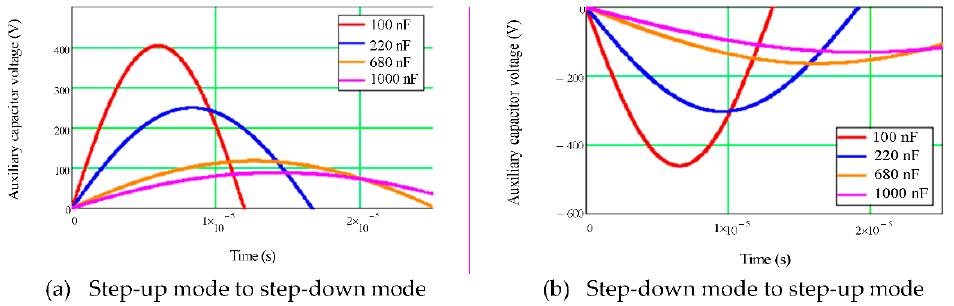
Figure 17. The transition time curve with different auxiliary capacitor values under the full- condition. load